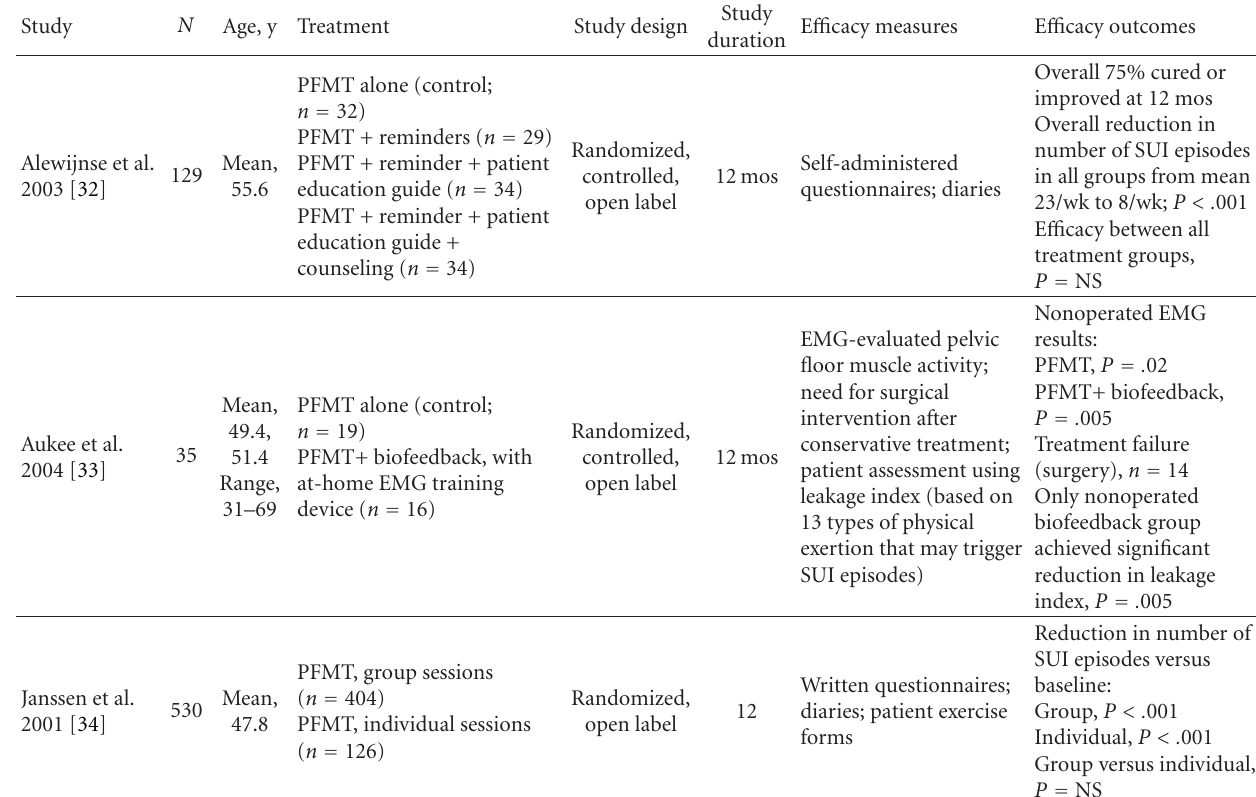
Table 1: Summary of conservative therapy